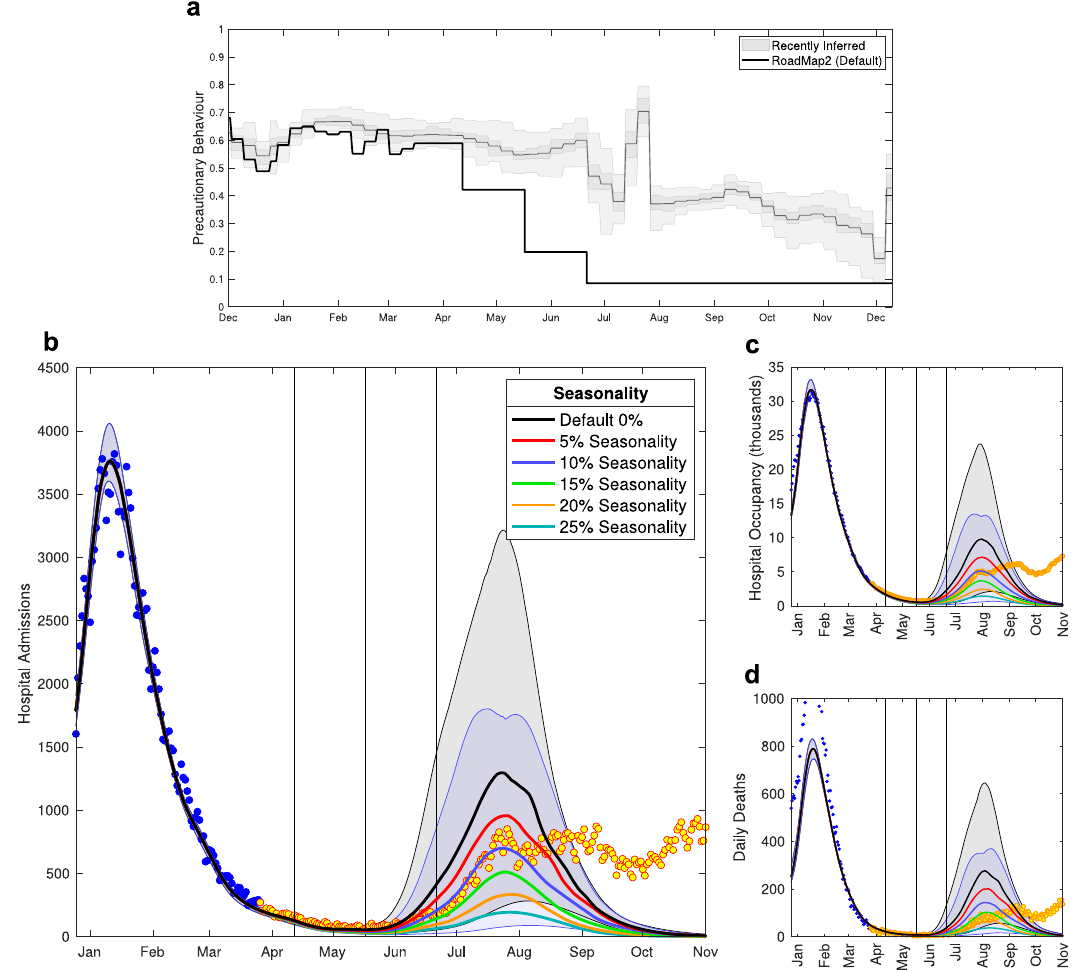
Fig. 4 | Severe disease projections from Roadmap 2 Figure 2.8 14 , which con- sidered the impact of seasonality. a The most recently inferred level of precau- tionary behaviour (grey, showing mean, 50% and 95% credible intervals) together with the assumed default levels from Roadmap 2 14 . Lower panels show the model outputs for daily hospital admissions b , hospital occupancy c and daily deaths d together with the associated data until December 2021; data points from before